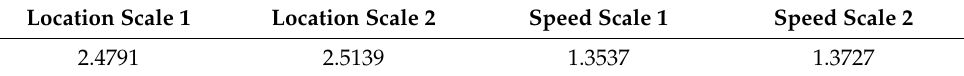
Table 5. Calculated scaling factors between different sensor locations and rod speed conditions.